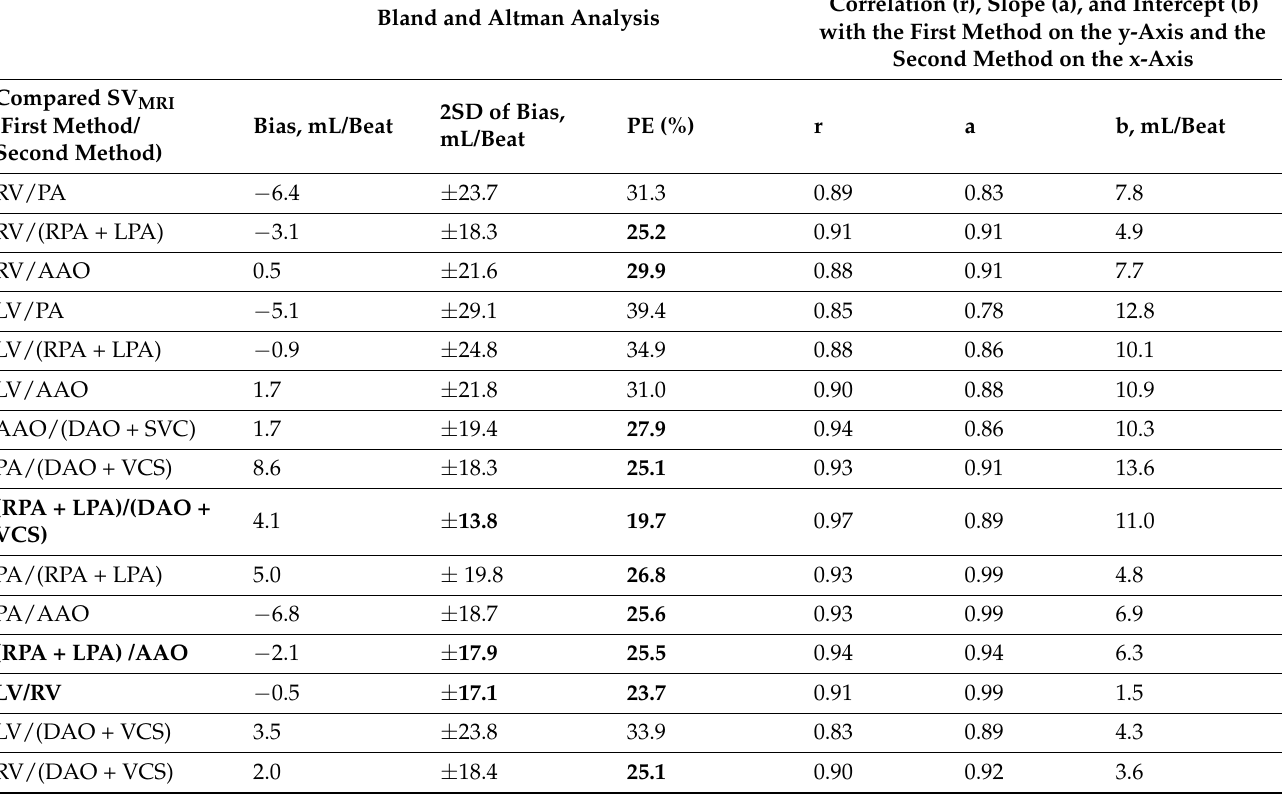
Table 5. Fifteen paired comparisons of the six different MRI methods. Bland and Altman Analysis